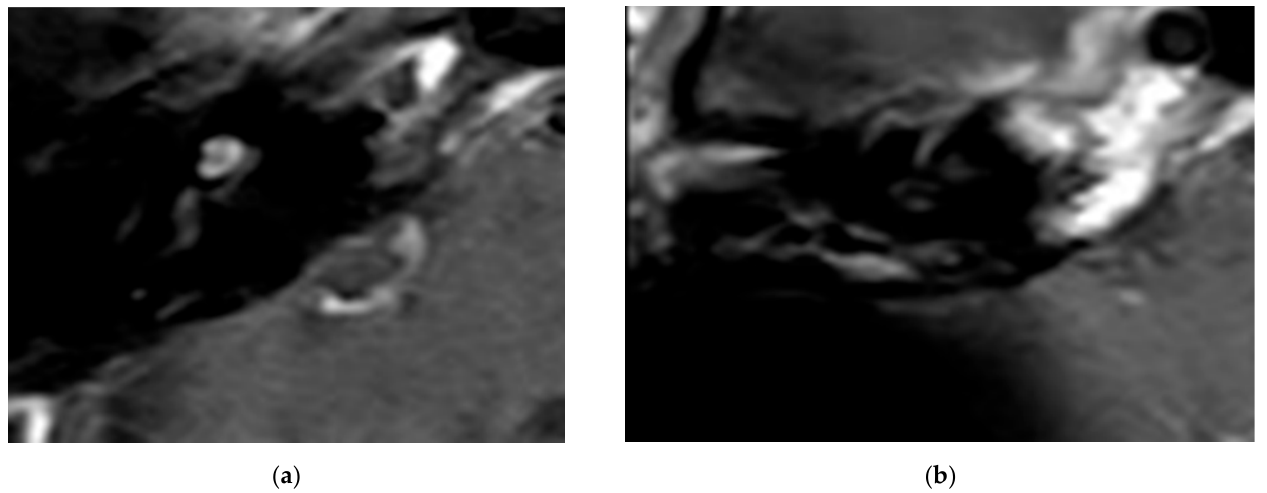
Figure 2. ( a ) . An exemplary ILS tumor pre-op (T1, Gad). ( b ) . The ILS region with a T1 Gad sequence after removal and CI. Figure 2. ( a ). An exemplary ILS tumor pre-op (T1, Gad). ( b ). The ILS region with a T1 Gad sequence after removal and